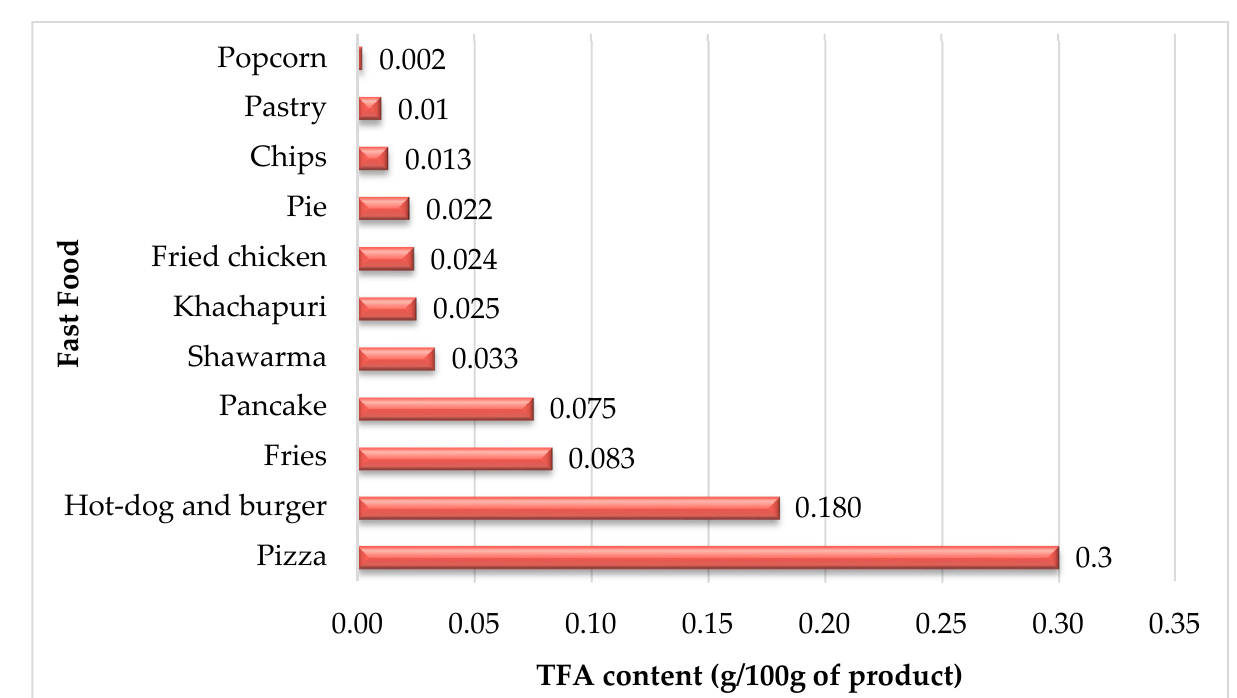
Figure 1. TFA Contents in Fast-Food (g/100 g).